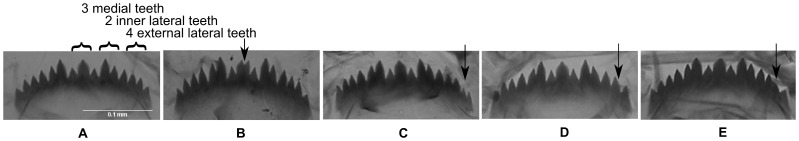
Normal and deformed mentum observed in chironomids exposed at lead and at 4-NP.Normal mentum (A), cleft median tooth (B), extra tooth (C), missing tooth (D), fusing teeth (E). Arrows indicate deformities.